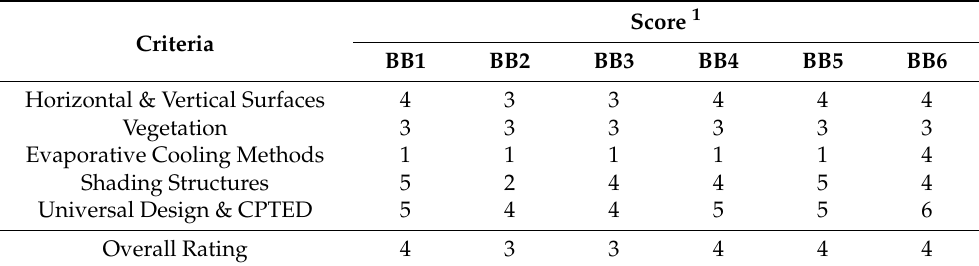
Table 2. Summarized HEDAT results for Bli